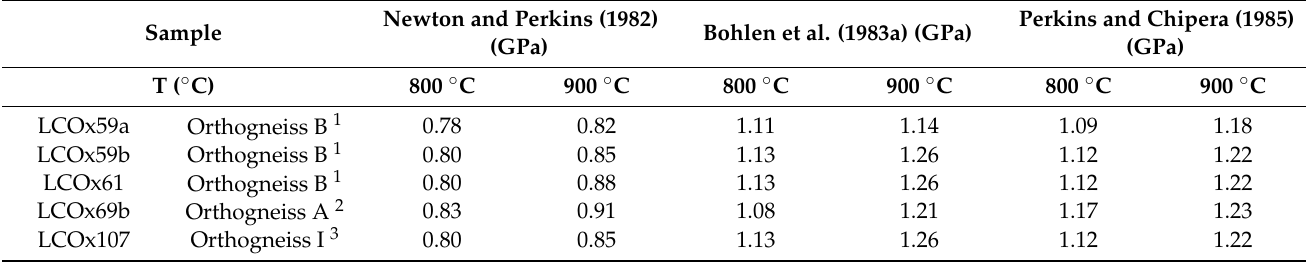
Table 2. Results of Grt-Opx-Pl-Qz geobarometer calibrations from [45–47] with two inputs of T: 800 ◦ C and 900 ◦ C.